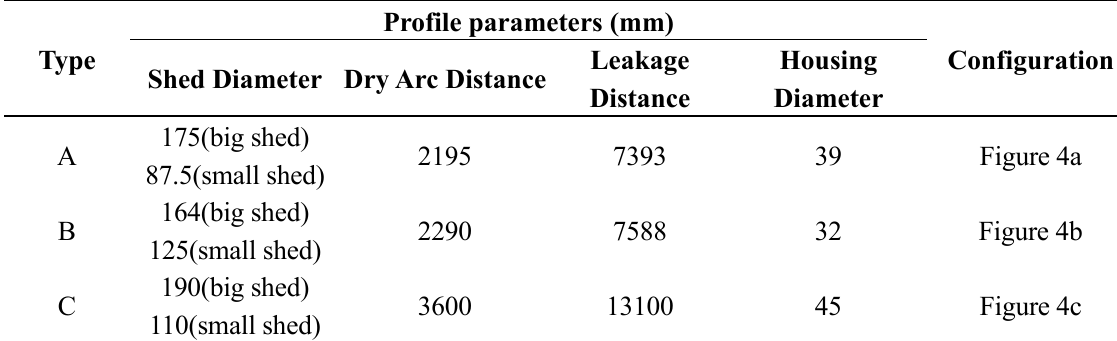
Table 2. Dimensions of the test composite insulators.